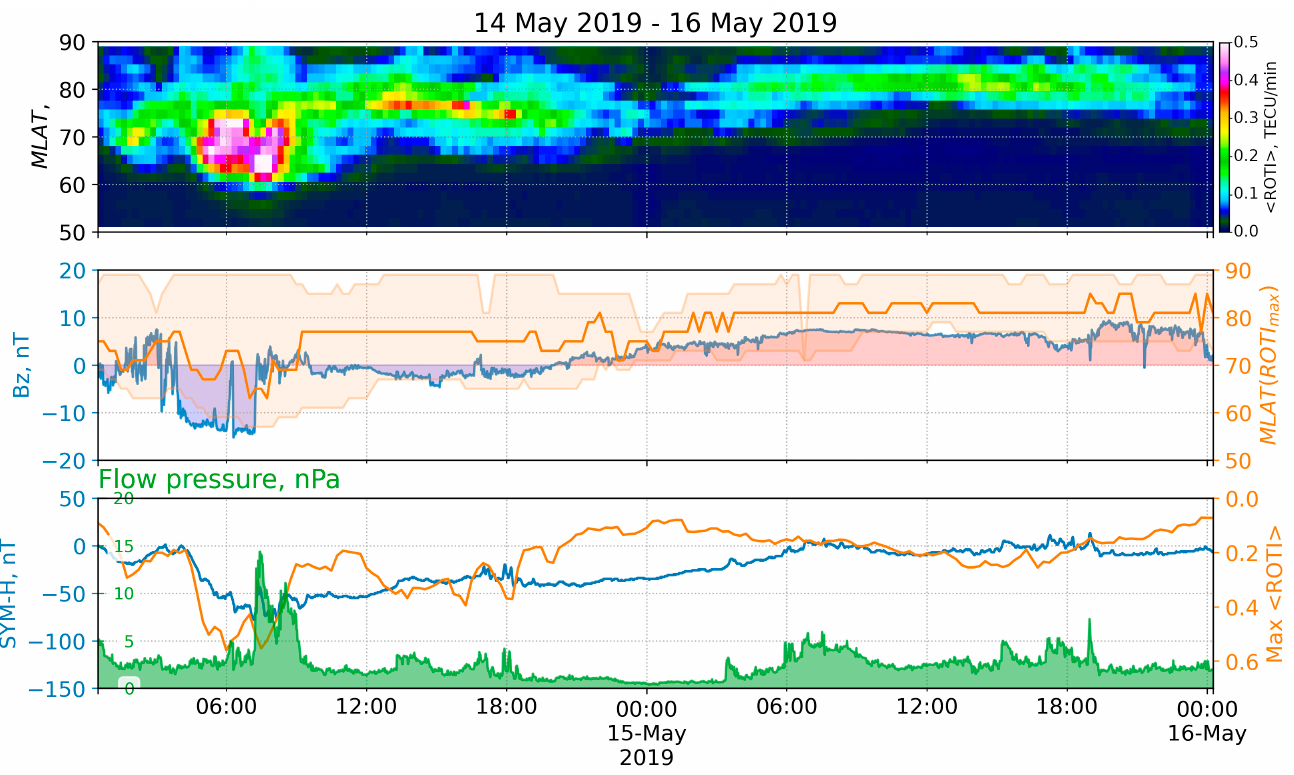
Figure 6. ROTI keogram and space weather parameters for the storm of 14 May 2019: ( top ) keogram of average ROTI (<ROTI> versus MLAT versus time); ( middle ) IMF Bz ( blue ), MLAT positions of maximum <ROTI> ( orange ), and values exceeding median ROTI at the moment ( orange filling ); ( bottom ) SYM-H index ( blue ), <ROTI> max ( orange ), and flow pressure ( green ).